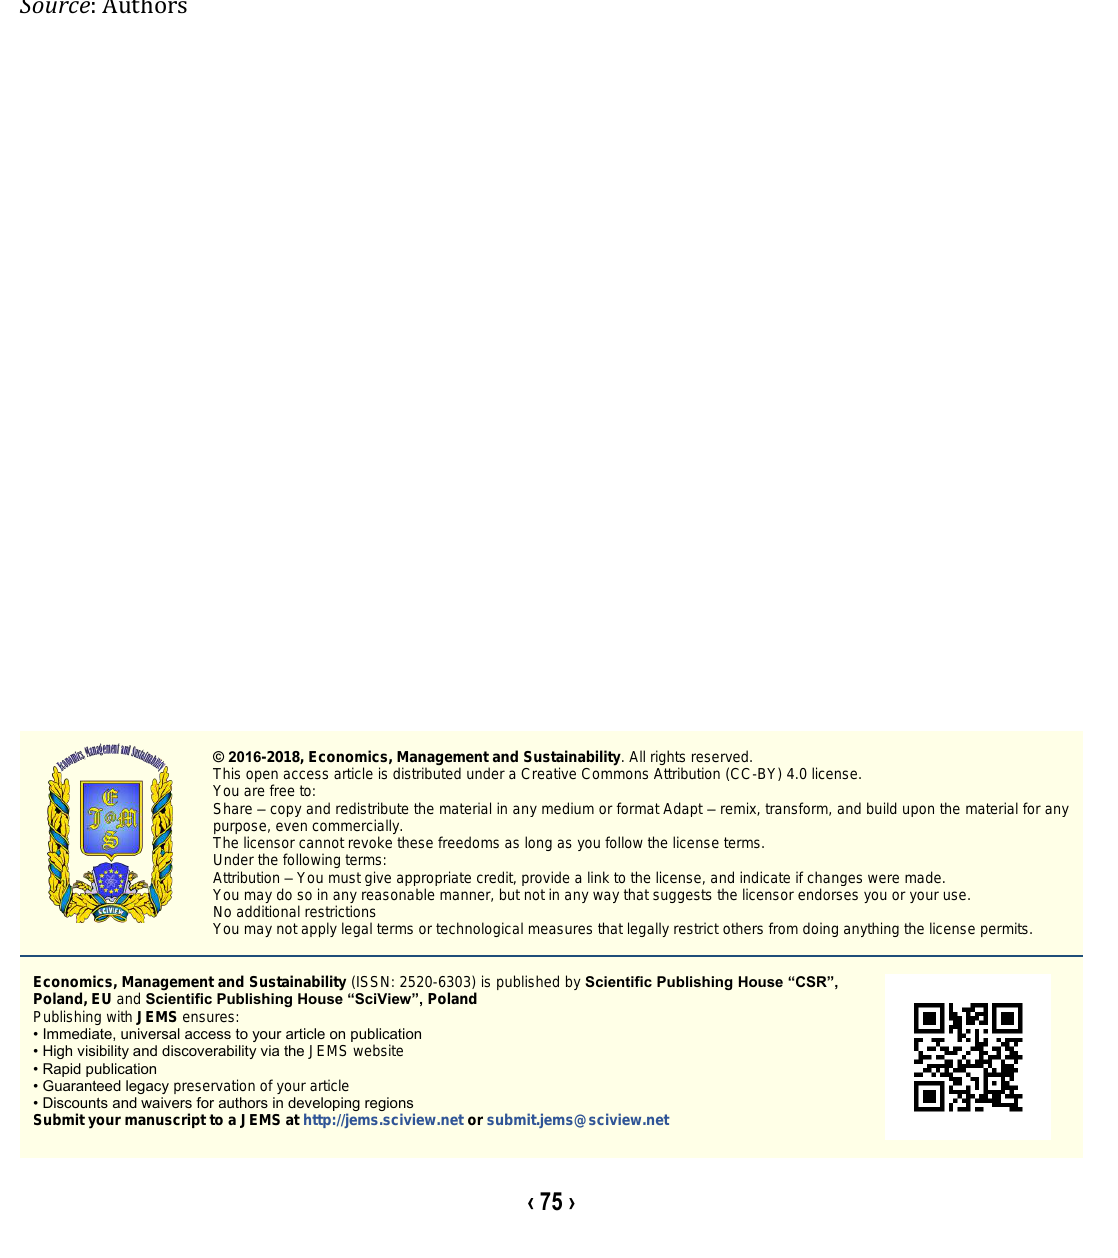
Stock company with executive